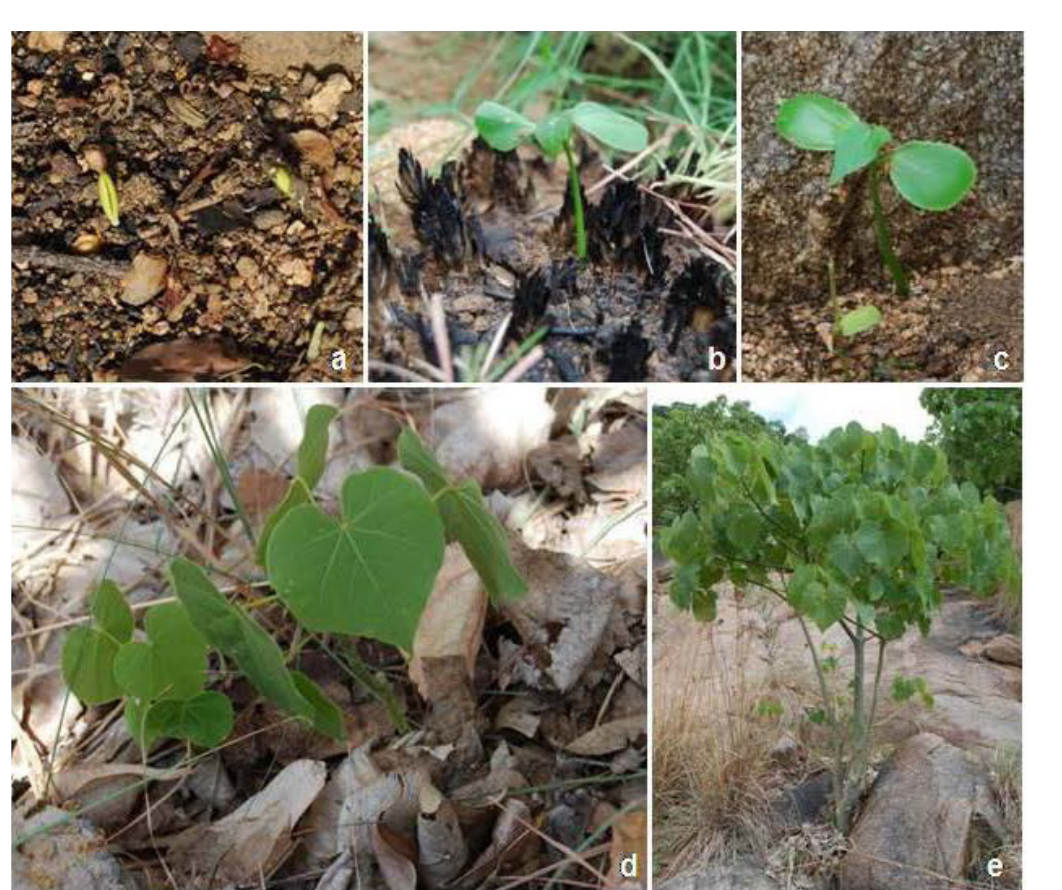
No. of trees used for collecting fruits: ten. Fruits collection was done